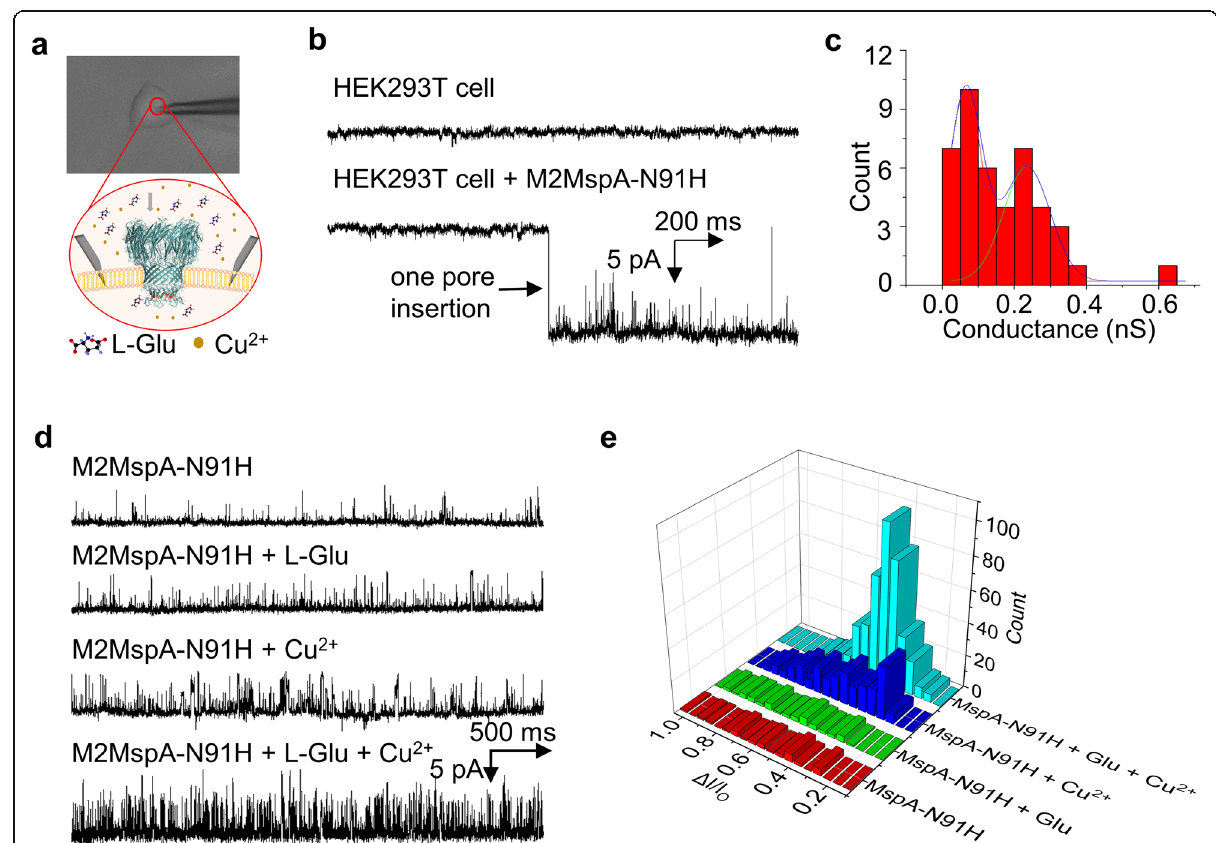
Fig. 4 L-Glu detection by M2MspA-N91H incorporated in single live HEK293T cell membrane. a Glass electrode on HEK293T cell membrane (patch-mode) and schematic drawing of one MspA-91H nanopore embedded in HEK293T cell membrane. b Typical current traces of blank (HEK293T cell) and one M2MspA-N91H nanopore inserting into HEK293T cell membrane (HEK293T cell + M2MspA-N91H). c Conductance histogram of M2MspA-N91H inserting into 293 T cells ( n = 43). d Typical current traces of M2MspA-N91H nanopore inserting into HEK293T cell membrane with 1 mM L-Glu and/or 200 μ M Cu 2+ at − 60 mV. e Current blockade 3D histogram of translocation signals from Fig. 4d. The buffer in the patch clamp pipette was 153 mM KCl, 10 mM HEPES, pH